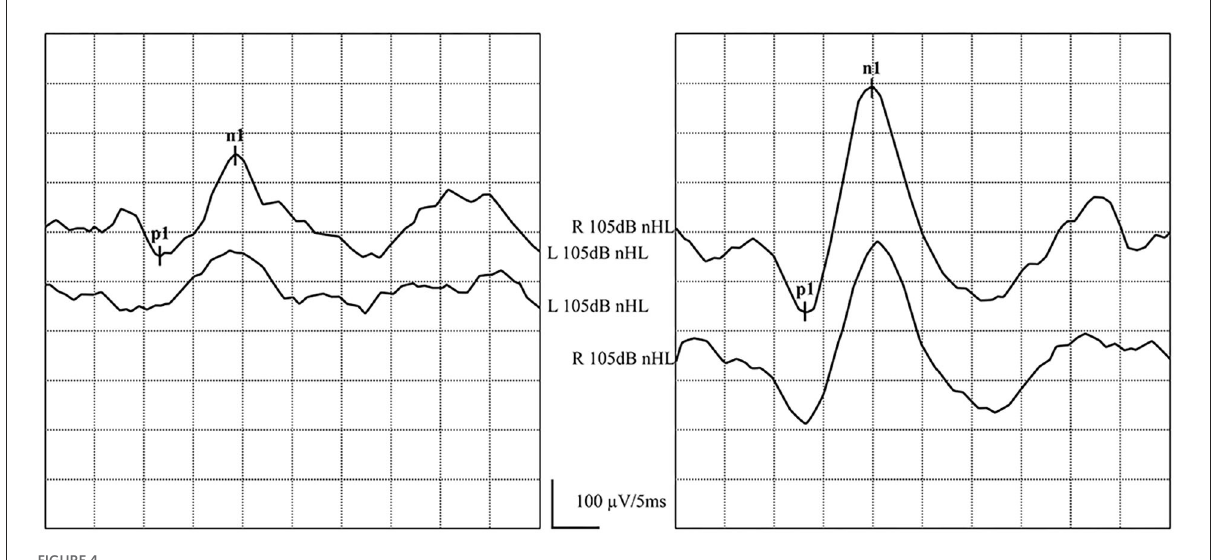
FIGURE4 Normal ACS-cVEMP waveforms: Elicited bilaterally and AR = 38%. (left) ACS-cVEMP waveforms were elicited on the left side. (right) ACS-cVEMP waveforms were elicited on the right side.